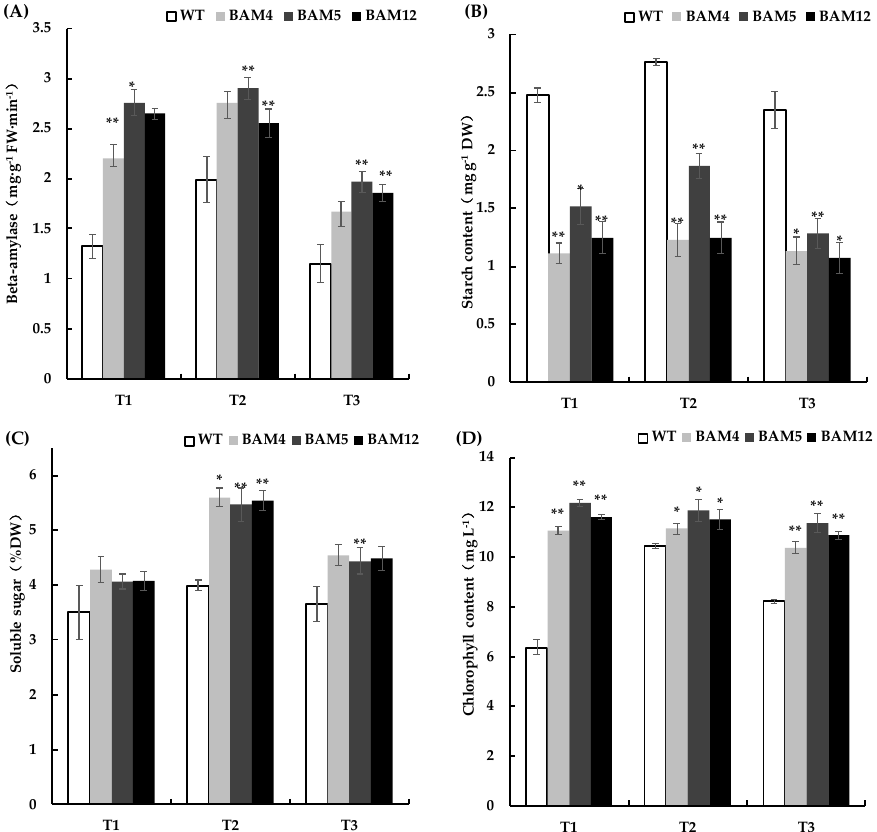
Figure 8. ( A ) β-amylase activity, ( B ) starch content, ( C ) soluble sugar, and ( D ) chlorophyll content in the DoBAM1-overexpressing lines and WT under different cold treatments. * and ** indicate a significant difference at p < 0.05 and p < 0.01 compared with WT, respectively.